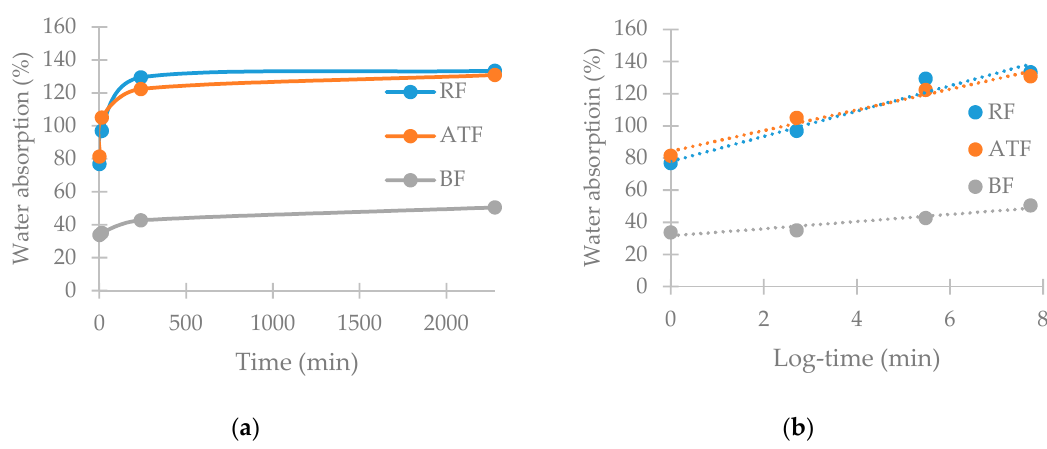
Figure 10. Water absorption of coconut fibers: ( a ) versus time; ( b ) logarithmic scale.